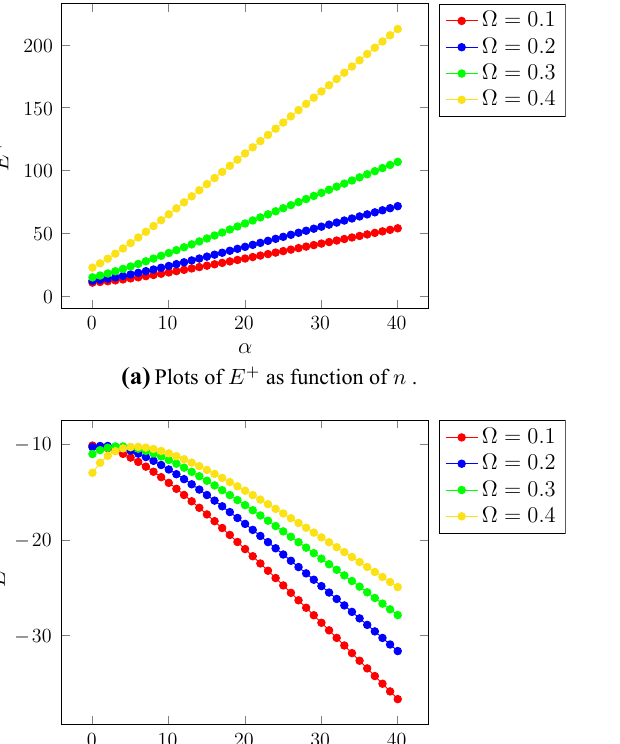
Fig. 3 Energy as a function of α . The constants are α = 0 . 5 , k = 1 , R = 1 , M = 10 , m =